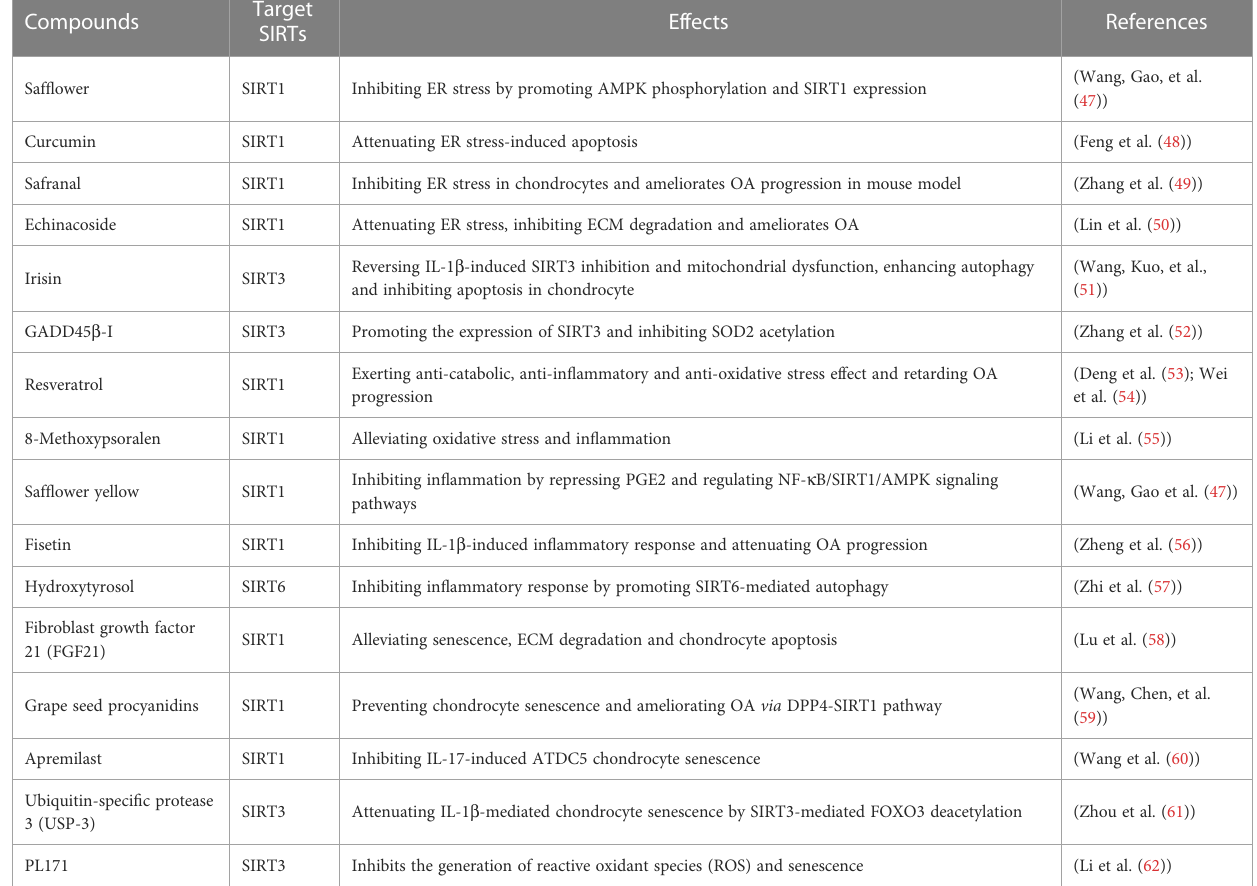
TABLE 2 Compounds targets SIRTs directly or indirectly in treating